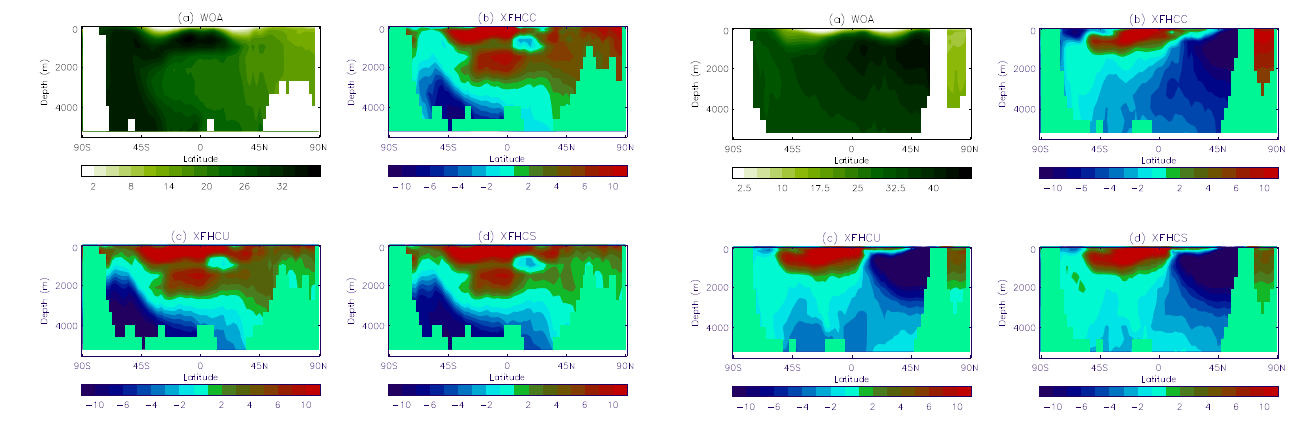
tuned to observations and reanalysis data and the climatolo- gies of the new versions of the model have been shown to be noticeably improved.